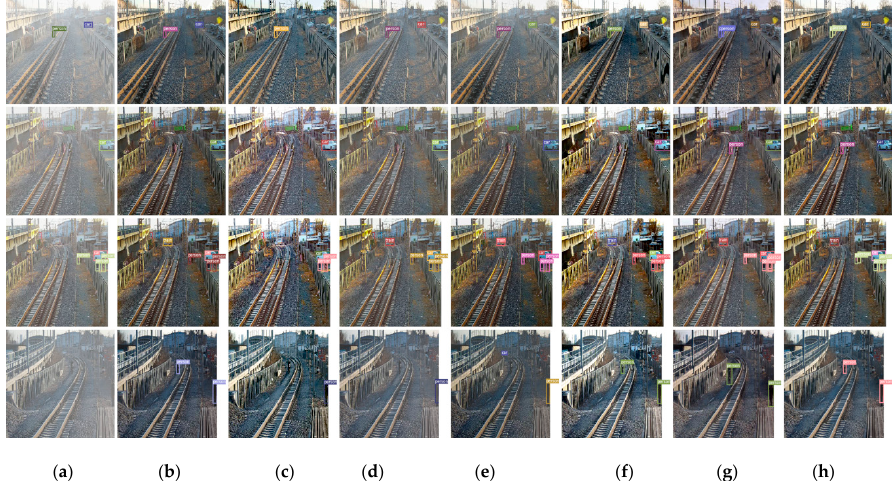
Figure 7. Comparison of object detection results on railway images with haze and after dehazing. ( a ) input hazy images + YOLOv3, and from ( b – h ) are dehazing images + YOLOv3. ( b ) He et al. [7], ( c ) Berman et al. [32], ( d ) Ren et al. [10], ( e ) Li et al. [11], ( f ) Zhang et al. [33], ( g ) Chen et al. [13], ( h ) ours.